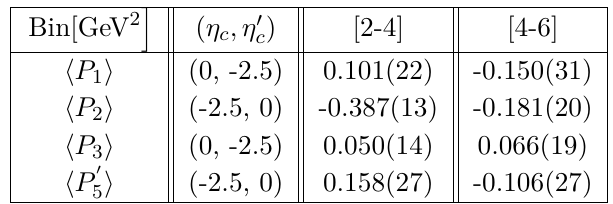
Table 49 . Predictions of observables for B ± → ρ ± ‘‘ decays on rescaling the charm vacuum polarisation by a factor of